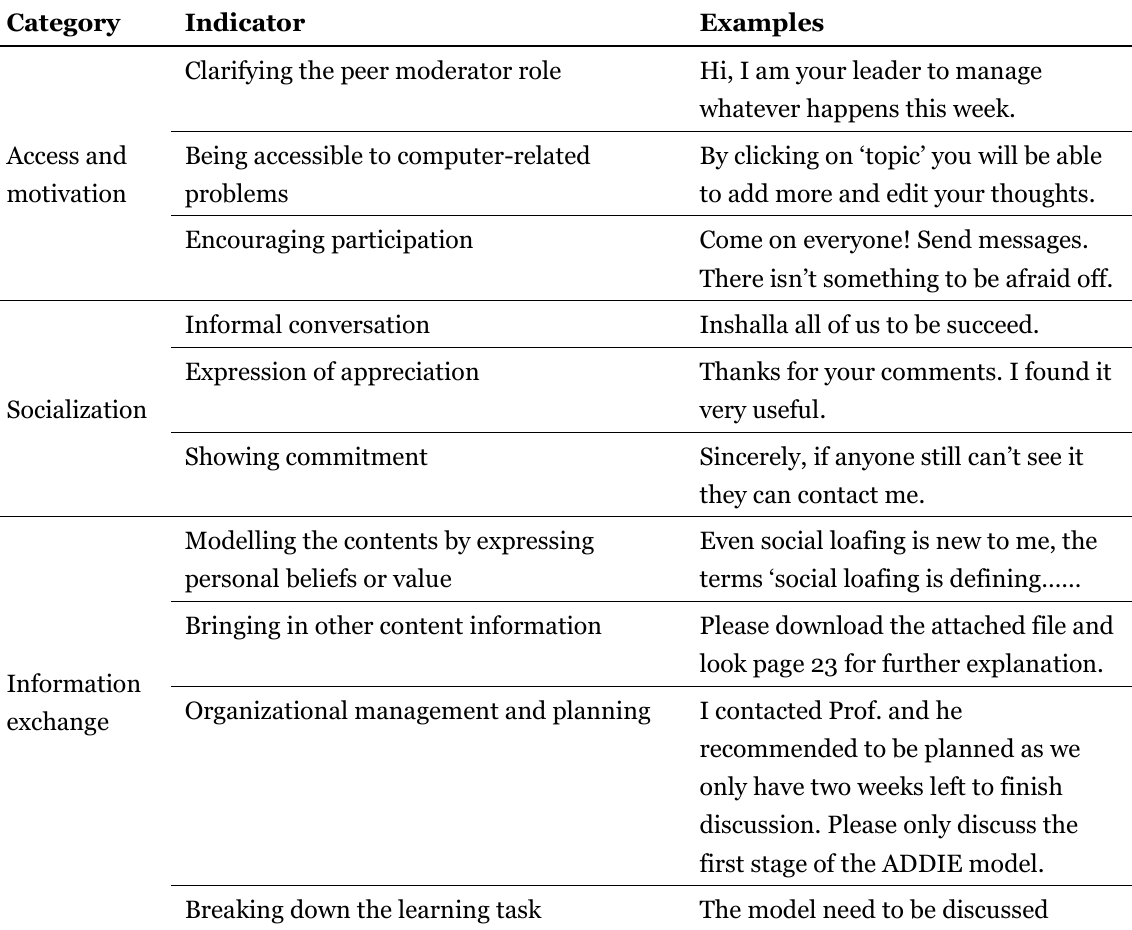
Coding Scheme for Analysis of Peer Moderators’ Discussion Content (Smet et al., 2010)